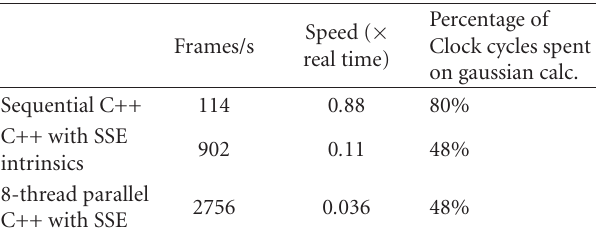
Table 1: Timing results for software